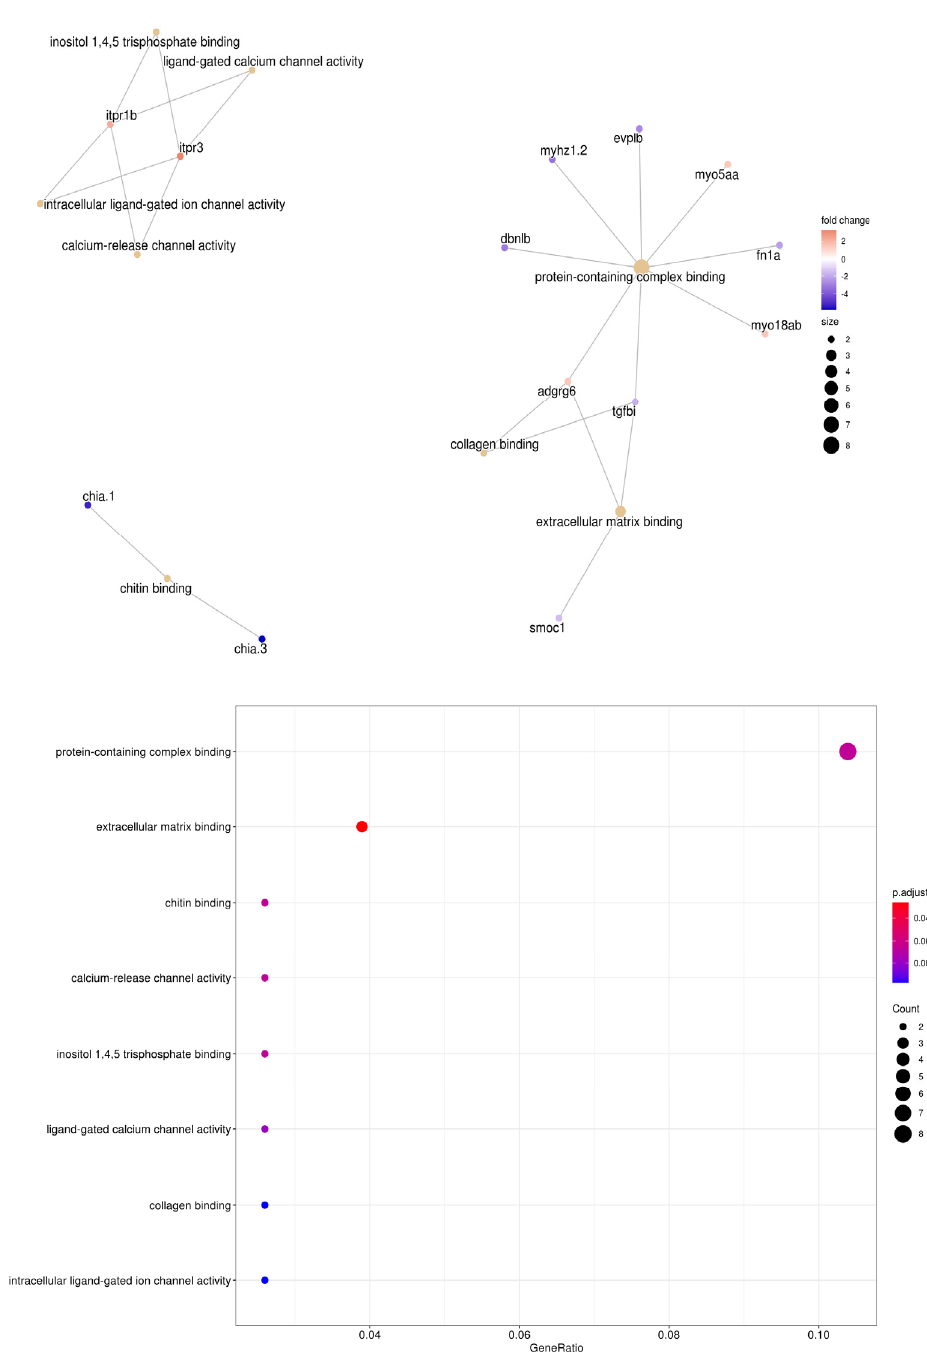
Figure 7. Significant functional enrichment network of the Biological process GO (adjusted p < 0.05), from the DEGs obtained in the comparison of the CW vs. PW skin. Brown nodes indicates functional categories. Red to blue nodes indicate the log 2 fold change values.